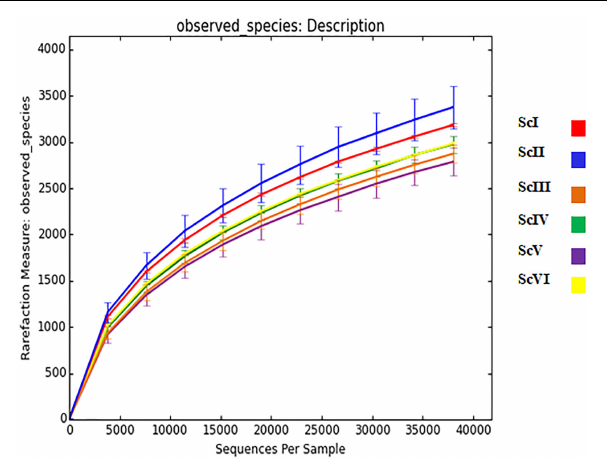
FIGURE 1 | Rarefaction analysis of six soil samples having different agriculture management systems. Where ; ScI, conventional rice-wheat system; ScII, partial CA based rice-wheat-mungbean system; ScIII, partial CSA based rice-wheat-mungbean system; ScIV, partial CSA based maize-wheat- mungbean system; ScV, full CSA based rice-wheat-mungbean system with sub surface drip irrigation; ScVI, full CSA based maize-wheat-mungbean system with sub surface drip irrigation.